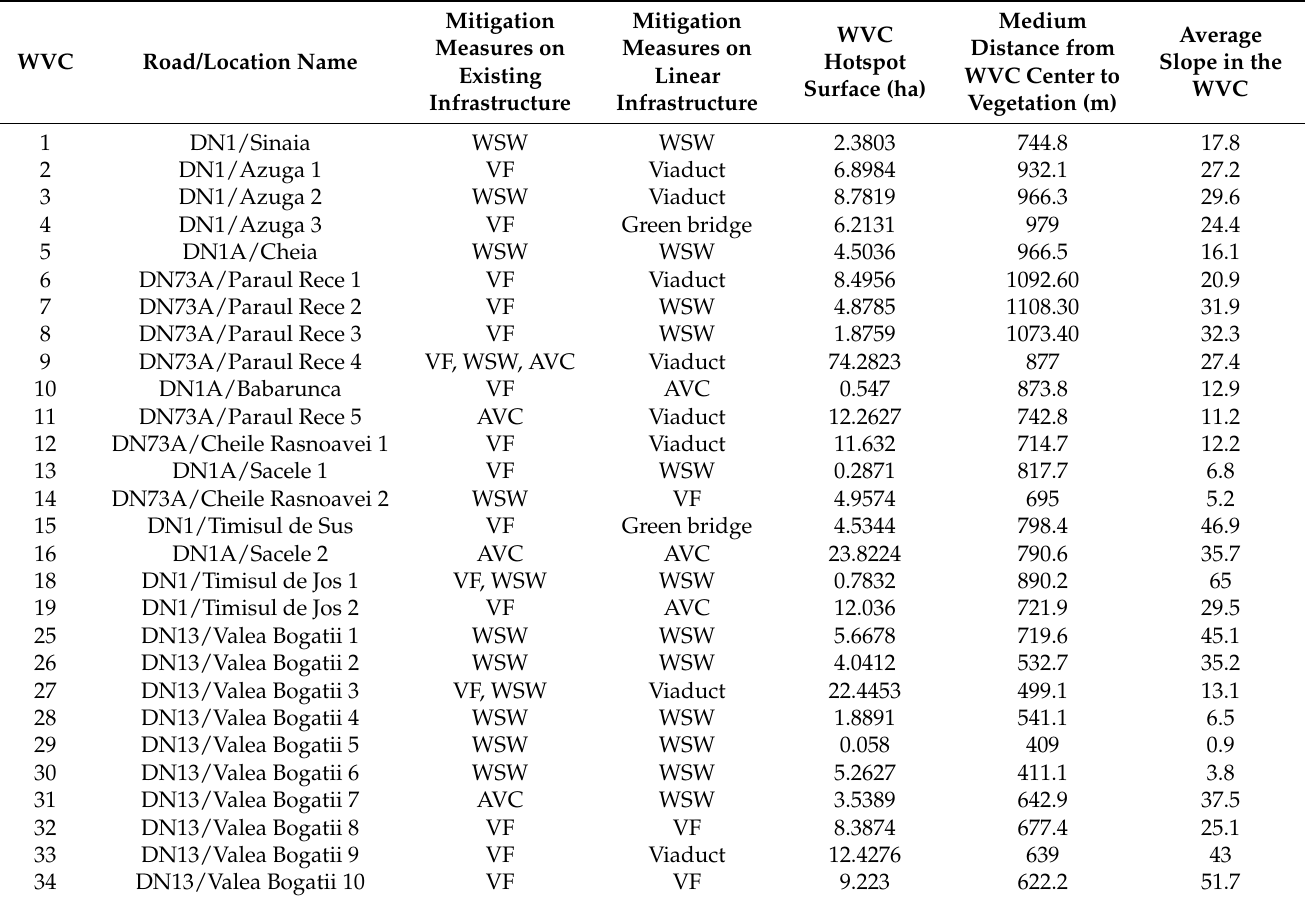
Table 3. Proposed mitigation measures for the existing and future infrastructure for each WVC hotspot.